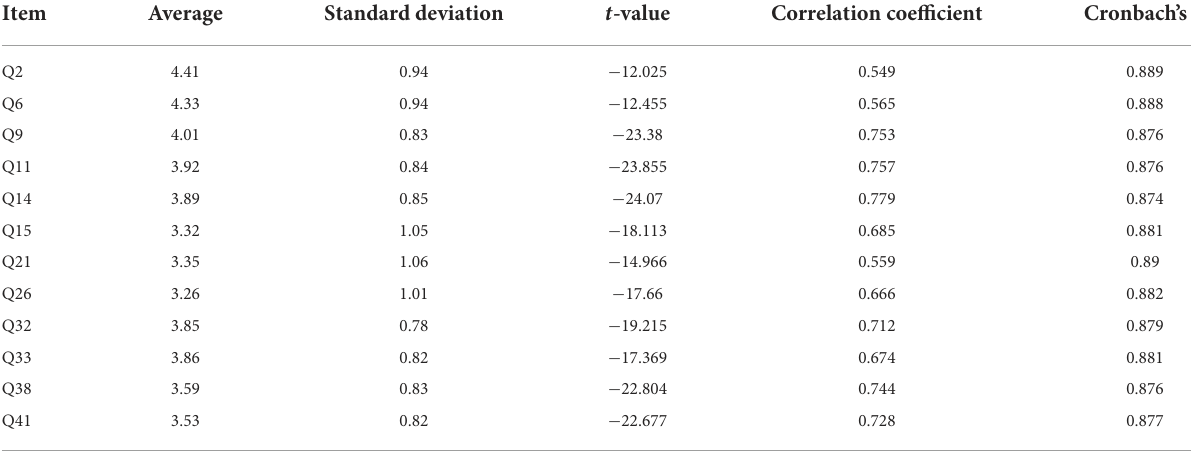
TABLE 3 Results of the NL-SF12 item analysis and descriptive statistics for all 12 items.